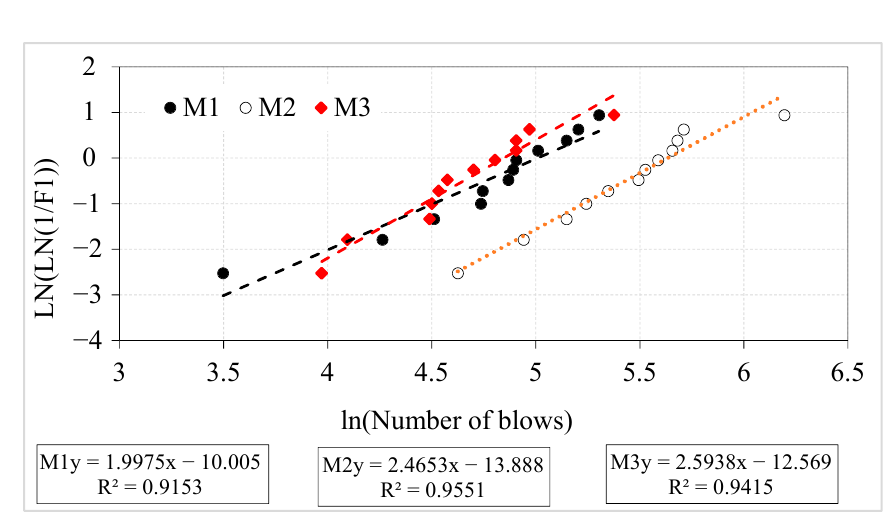
Figure 4. Weibull lines for mixes M1, M2, and M3.